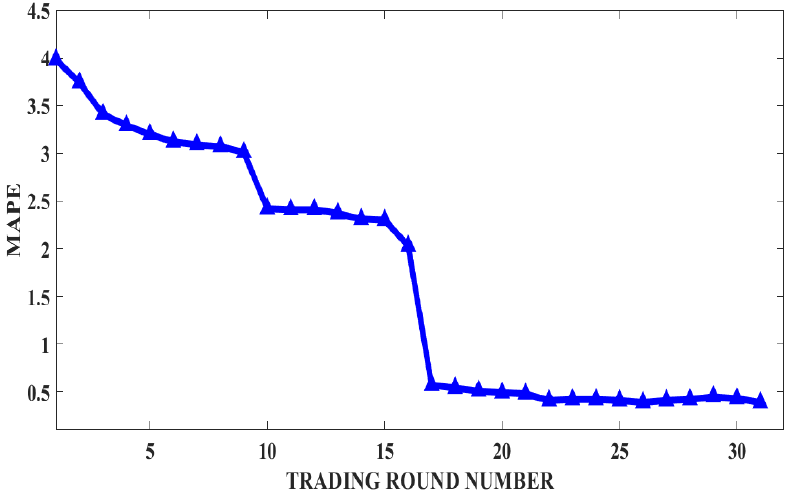
Figure 4. GRU prediction model performance evolution as the trading rounds go